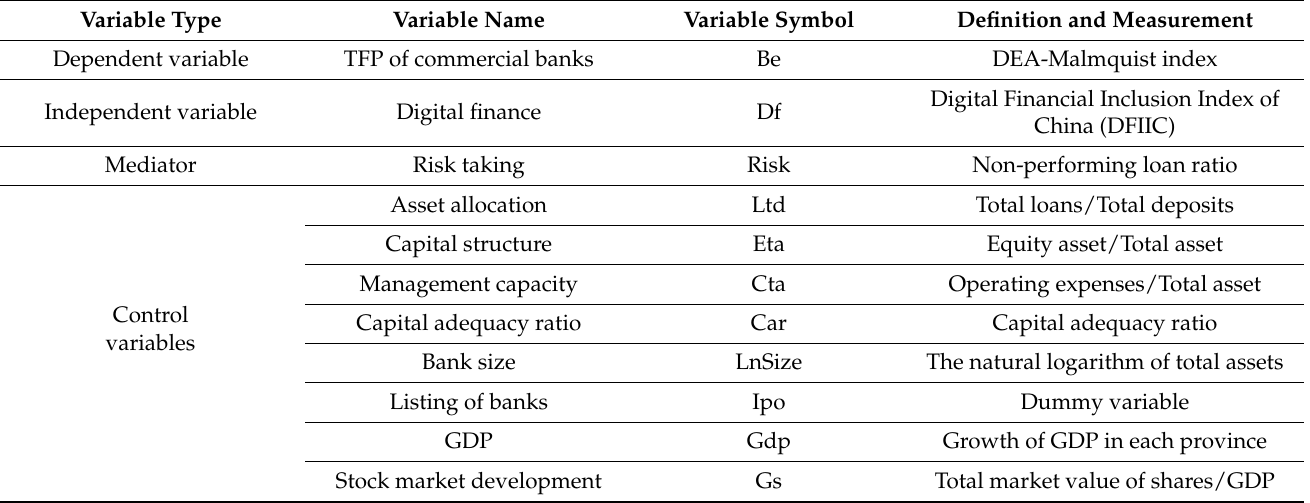
Table 2. Definition of